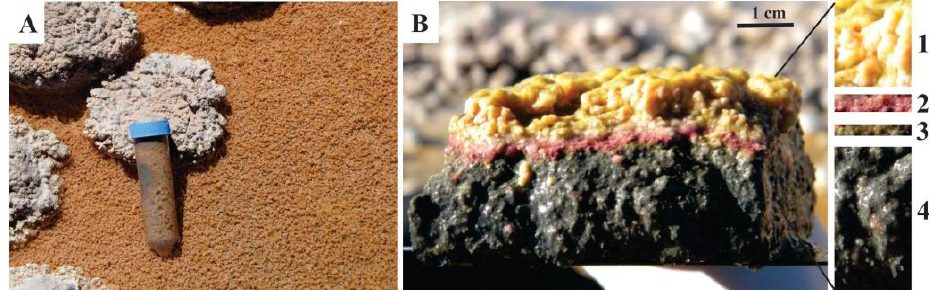
Figure 2. Studied microbial mat. ( A ) Overview; ( B ) Vertical section of one portion of the microbial mat showing the four dissected layers: pink-orange Layer 1, purple Layer 2, green Layer 3, and black Layer 4.